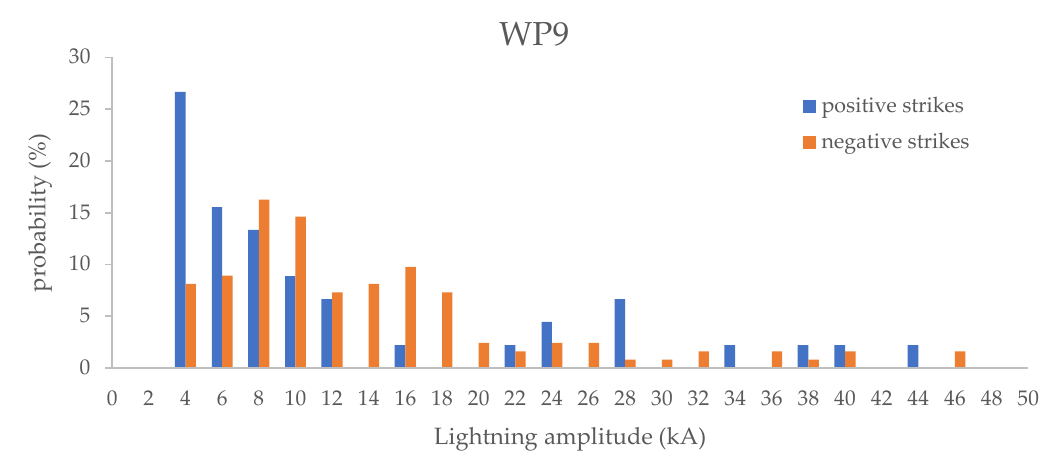
Figure A9. Lightning current amplitude probability distributions for positive and negative strikes extracted from the recorded incidents throughout the period 2011–2020 for WP9.